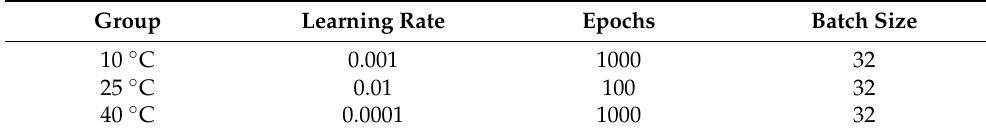
Table 5. The optimum parameter of the ANN